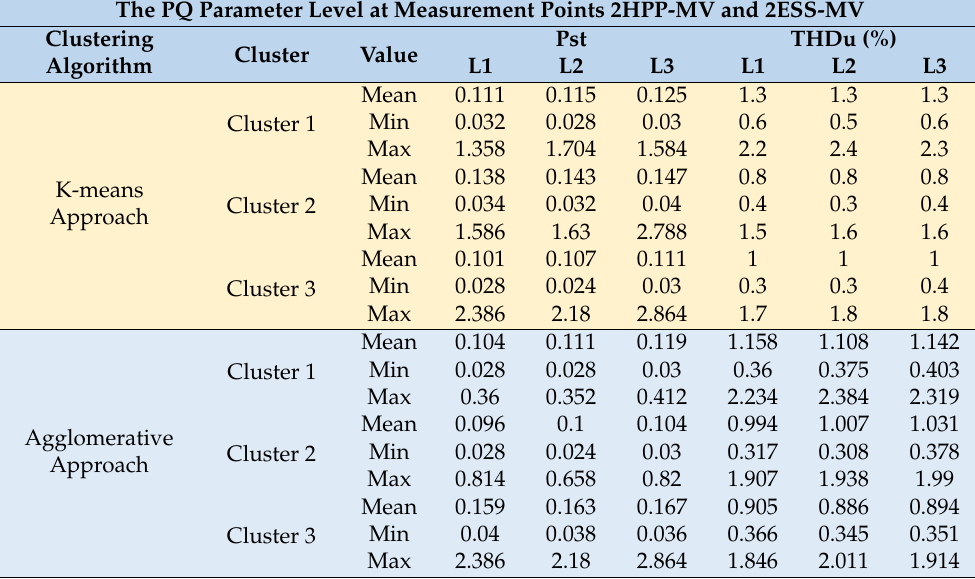
Table 2. Comparison of PQ level for different clusters on the first investigation object.